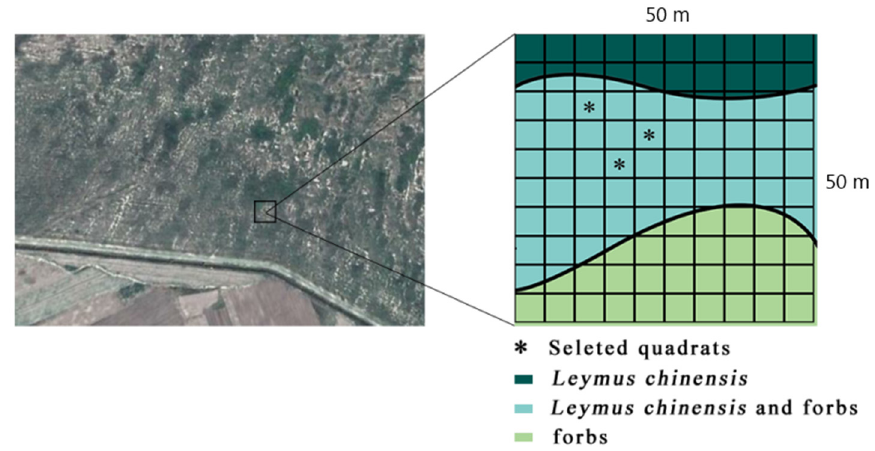
Figure 2. Sampling layout.